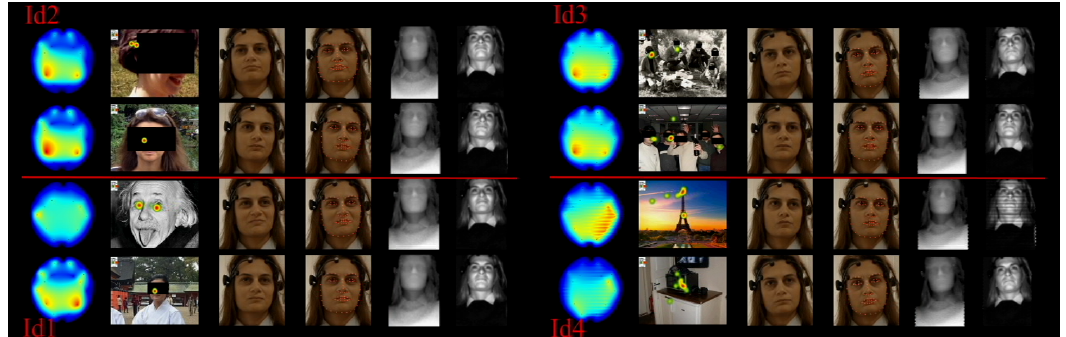
Figure 4. Different data modalities recorded from third task the SEMdb. The left figure shows, from top to bottom, ( Id1 )images of people from distant vs. recent past; and ( Id2 )famous vs. unknown people. The right figure shows from top to bottom ( Id3 ) images of groups of people from distant vs. recent past; and ( Id4 )famous vs. unknown places